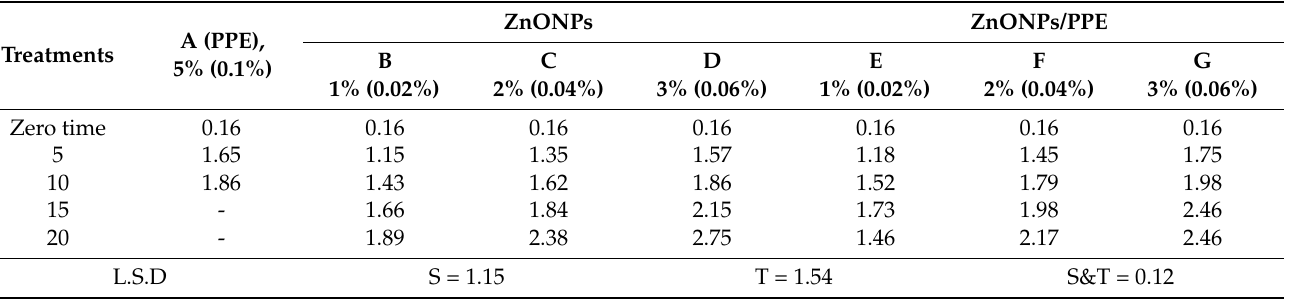
Table 12. Effect of edible film and coatings on moulds and yeast of manfalouty pomegranate during storage at 2 ◦ C.